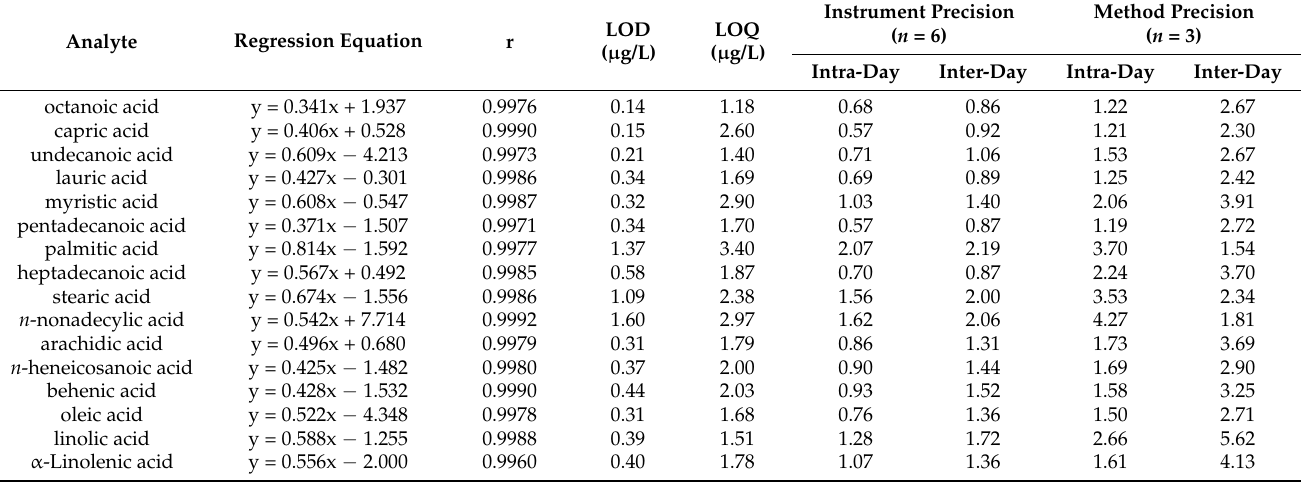
Table 5. Linear regression equation, correlation coefficients, limits of detection (LODs), limits of quantification (LOQs), reproducibility of retention time and the peak area, and intra- and inter-day precisions.